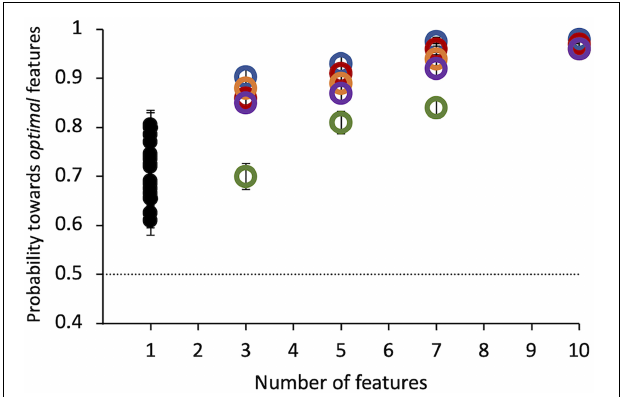
FIGURE 4 | Experiment 1: Probability of selecting the target as a function of the number of features. Colored symbols represent data from 5 individual observers. Black symbols represent data from 20 different individual observers, tested in this condition only. Errors of individual dots are binomial standard deviations. The dashed line indicates the guessing level for this task (0.5